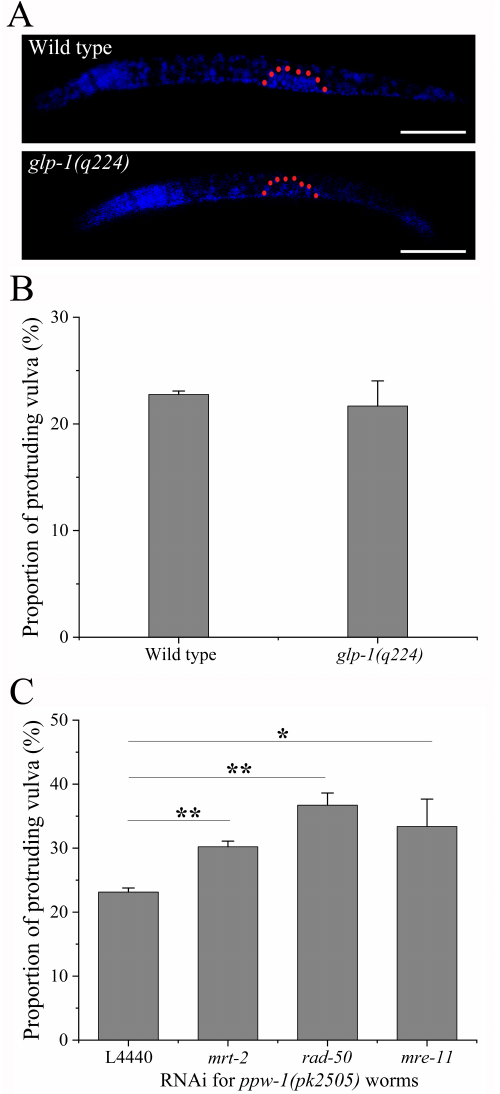
Figure 1. Participation of somatic DDR in regulating vulval radiosensitivity of C. elegans : ( A ) DAPI staining of N2 and glp-1 worms at the age of 13 h at 25 ◦ C, and gonad region is outlined by the dotted red line, scale bar: 50 µ m; ( B ) the radiosensitivity of reproductive death of vulval cells in glp-1 worms, which is evaluated by the proportion of protruding vulva; ( C ) the vulval radiosensitivity of ppw-1 worms subjected to RNAi of the mrt-2 , mre-11 , and rad-50 genes, respectively. Results are means ± SD ( n ≥ 3, t -test, * p < 0.05 and ** p <